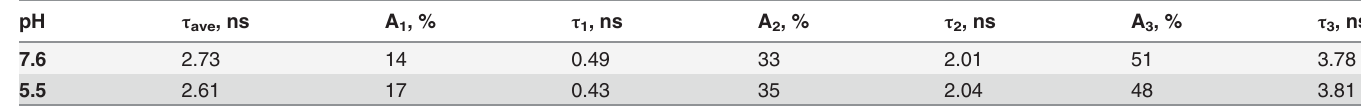
Table 6. Decay kinetics of LHCBM1 reconstituted in vitro at different